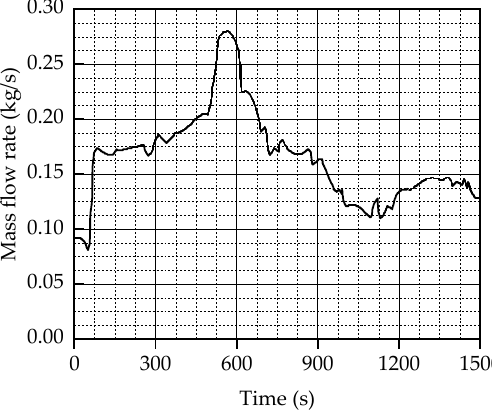
Figure 11. Gas mass flow rate vs. time [37].